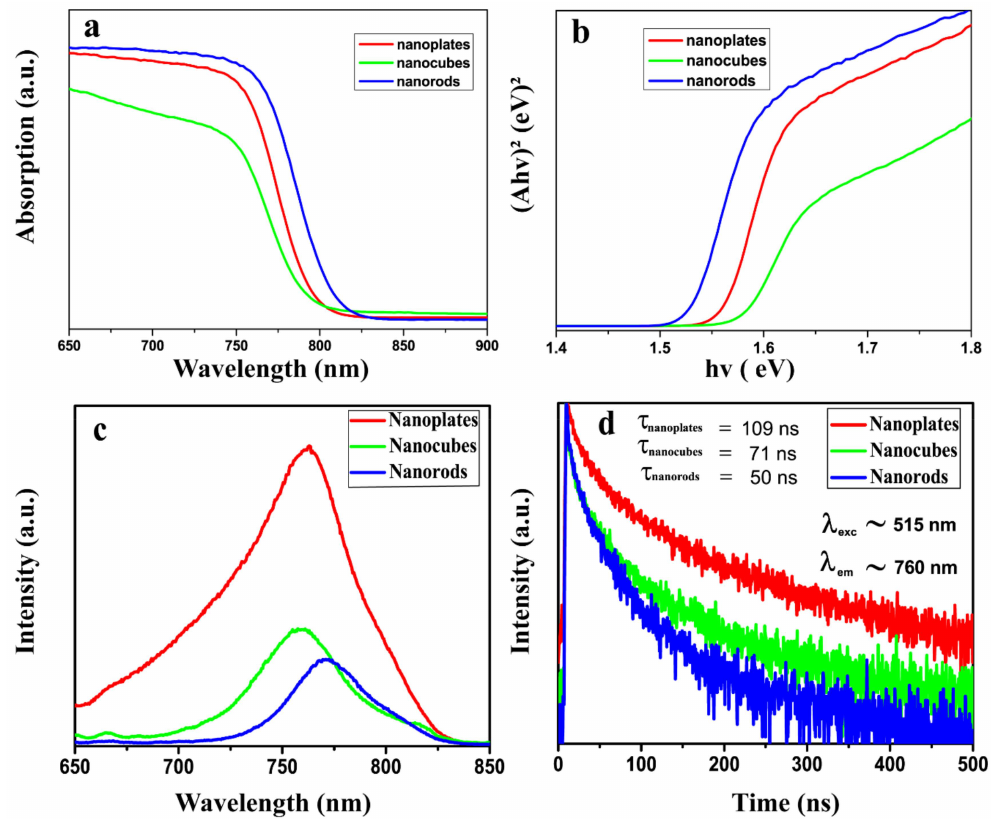
Figure 6. ( a )Visibleabsorptionspectrum, ( b )directbandgaptaucplots, ( c )steady-statephotoluminescence,